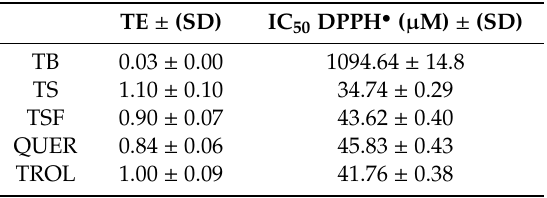
Table 4. Potential of the tested derivatives and selected reference compounds 6-hydroxy-2,5,7,8- tetramethylchroman-2-carboxylic acid expressed as TROLOX equivalents (TE) ( µ M antioxidant / µ M TROLOX) and as IC 50 values. Results obtained after 30 min of DPPH • (200 µ M) radicals reduction reaction at 25 ◦ C. QUER: